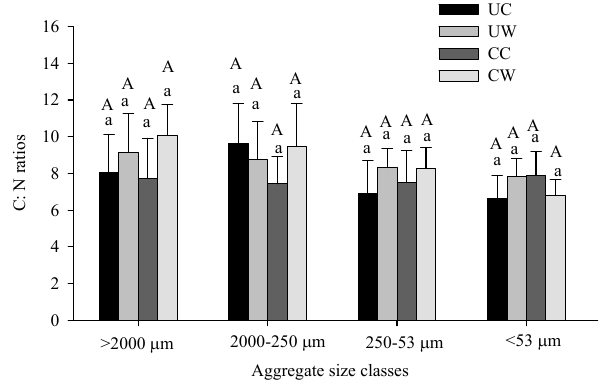
Fig. 2. C:N ratios of aggregate size classes under four treatments after nine years of warming and clipping. See Fig. 1 for the expla- nation of the symbols.